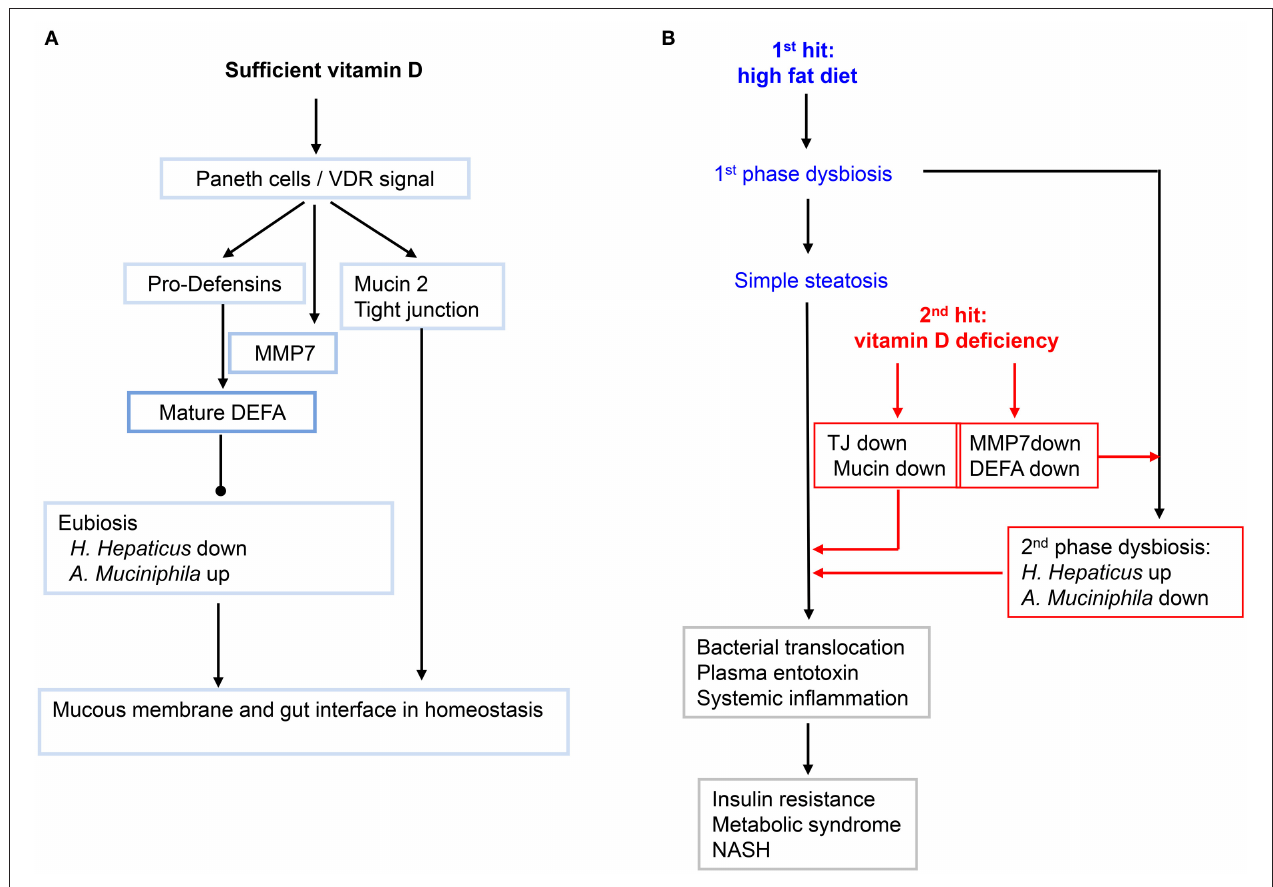
FIGURE 8 | A working model showing how vitamin D and its signaling in maintain the homeostasis of gut microbiota, and how lacking of vitamin D may exacerbate the high-fat-diet initiated fatty liver and metabolic syndromes. (A) Sufficient VD and its signaling in maintaining the integrity of small intestine. Gut VDR/Paneth-cells/defensins axis may configure the enterotype of microbiota in eubiosis. Moreover, VD signal up regulates the key components of tight junctions and mucin. (B) The primary dysbiosis initiated by HFD is worsened by hypovitaminosis D into second-phase dysbiosis that promotes systemic and hepatic inflammation, leading to insulin resistance, fatty liver and metabolic syndromes, and even transition of simple steatosis and into